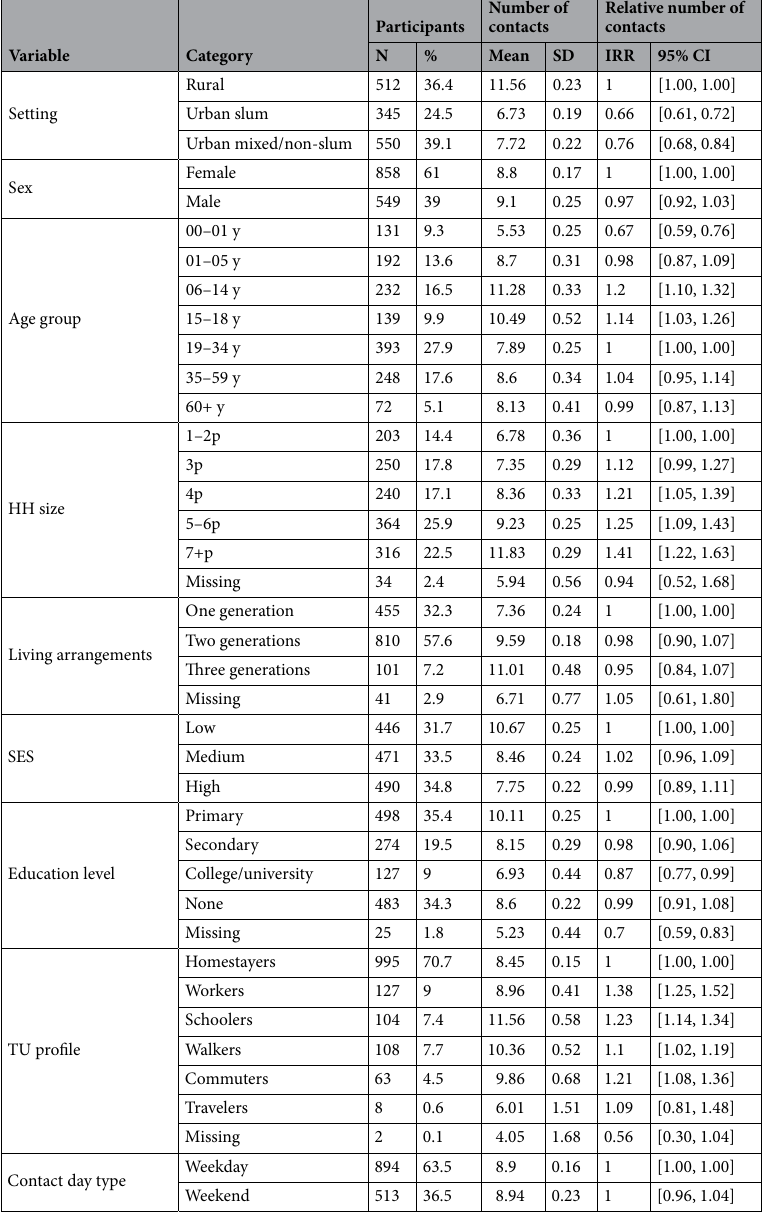
Table 1. Characteristics of participants and their daily contacts. The relative numbers of daily contacts (incidence rate ratio, IRR) were obtained from a GEE model with negative binomial distribution and overdispersion parameter equal to 0.14, 95% CI [0.13,